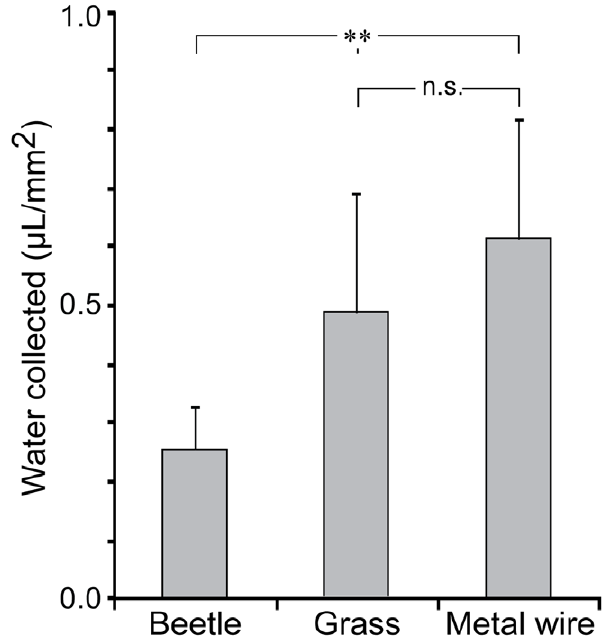
Figure 3. Fog water collection. Fog water collection (mean plus standard deviation) per mm 2 of the experimental objects upper surface